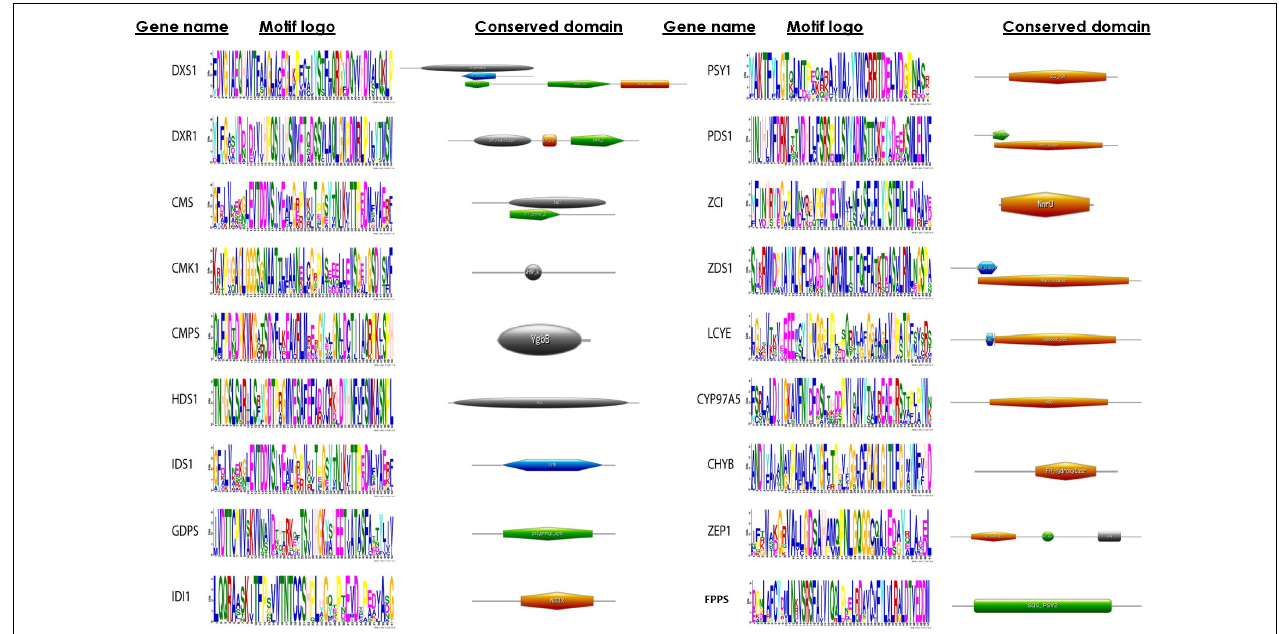
FIGURE 4 | Conserved sequence logo plots representing motifs and domain architecture of methyl erythritol phosphate (MEP) pathway genes constructed using MEME suite and HMMER tool, respectively. In the sequence logo plot, the height of symbol represents the relative frequency of amino acid conserved at that position, whereas the color corresponds to nature of amino acid (such as DE, magenta; KR, red).